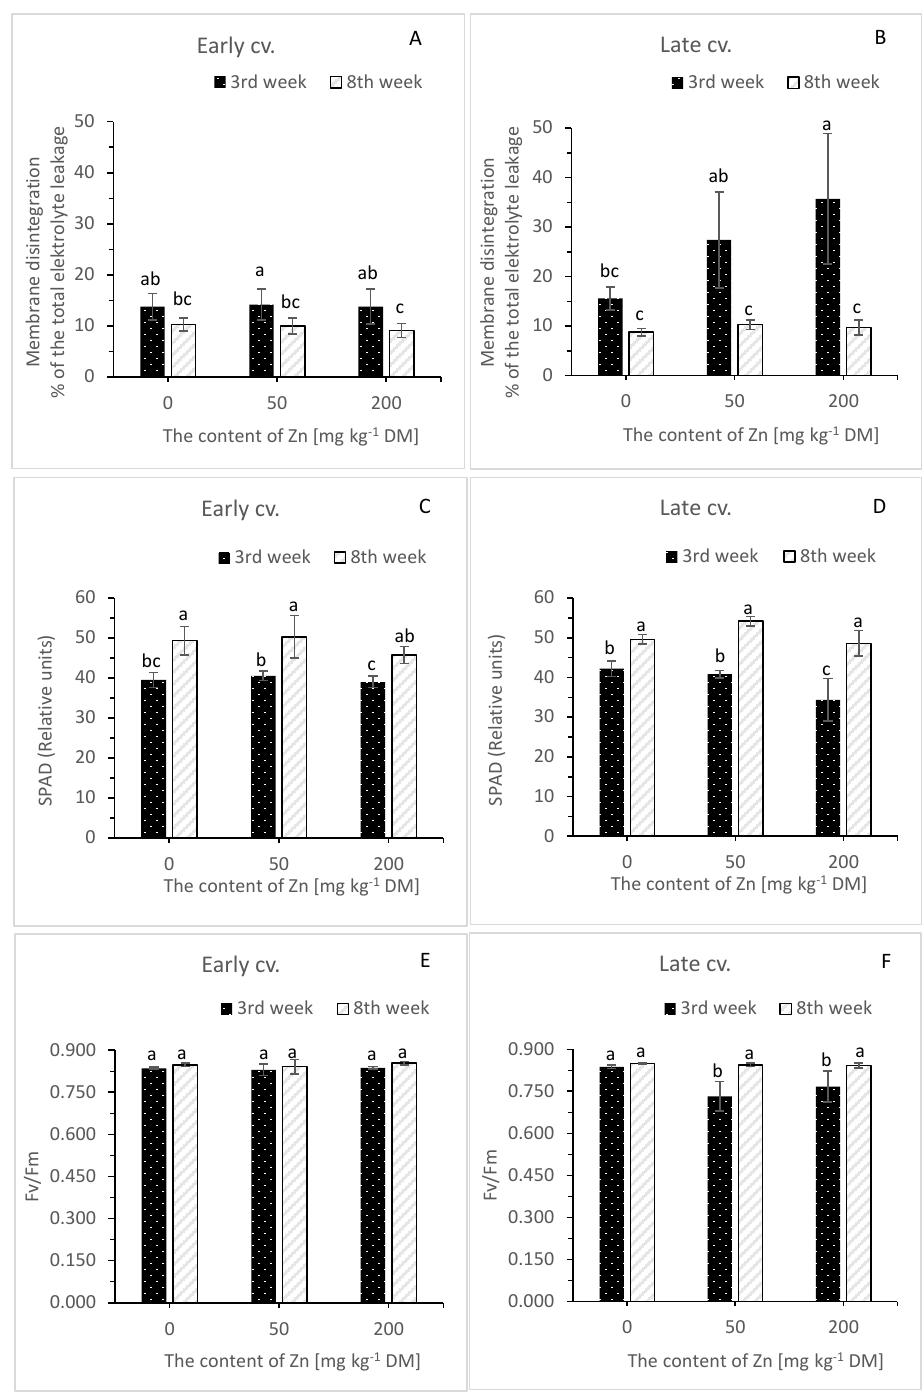
Figure 1. The influence of zinc on leaf membrane disintegration ( A , B ), SPAD values ( C , D ) and F v /F m parameter ( E , F ) of chlorophyll fluorescence (CF) of white cabbage at the 3rd and 8th weeks of growth. The natural content of zinc in the Zn0 (control) object was 118.13 [mg kg − 1 DM]. SPAD— Soil–Plant Analyses Development (greenness index), F v /F m —photochemical efficiency of PSII at the dark-adapted state. Note that n = 4, means ± SD are given. Means labelled with different letters are significantly differentiated within a date for a cultivar ( p < 0.05; Tukey’s